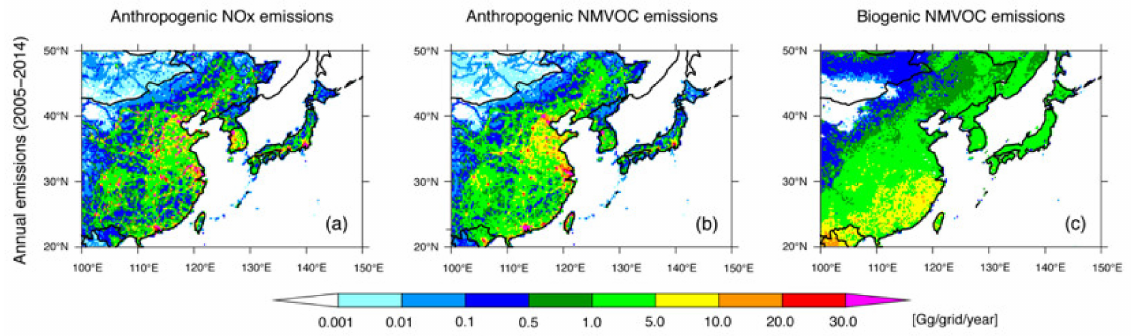
Figure A3. Anthropogenic ( a ) NO x and ( b ) NMVOC emissions and ( c ) biogenic NMVOC emissions over East Asia as averaged during